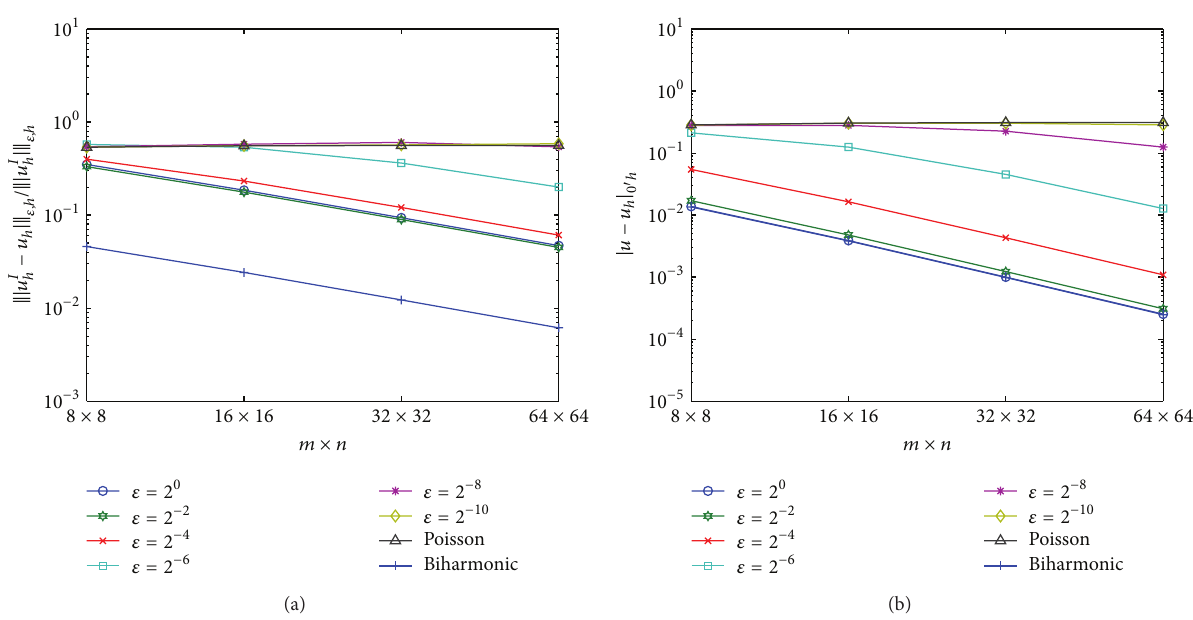
Figure 4: The errors ‖|𝑢 − 𝑢 ℎ |‖ 𝜀,ℎ /‖|𝑢|‖ 𝜀,ℎ and ‖𝑢 − 𝑢 ℎ ‖ 0 under mesh 1 in the formulation (12).